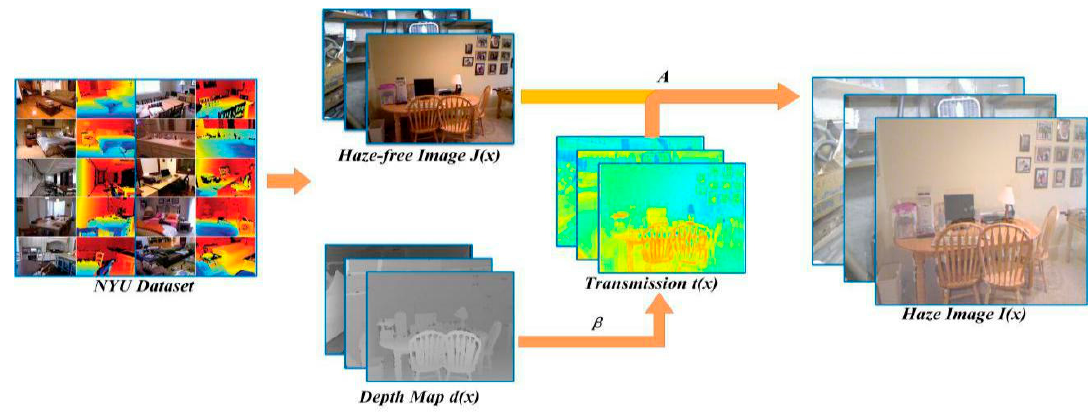
Figure 2. The formation of haze images.